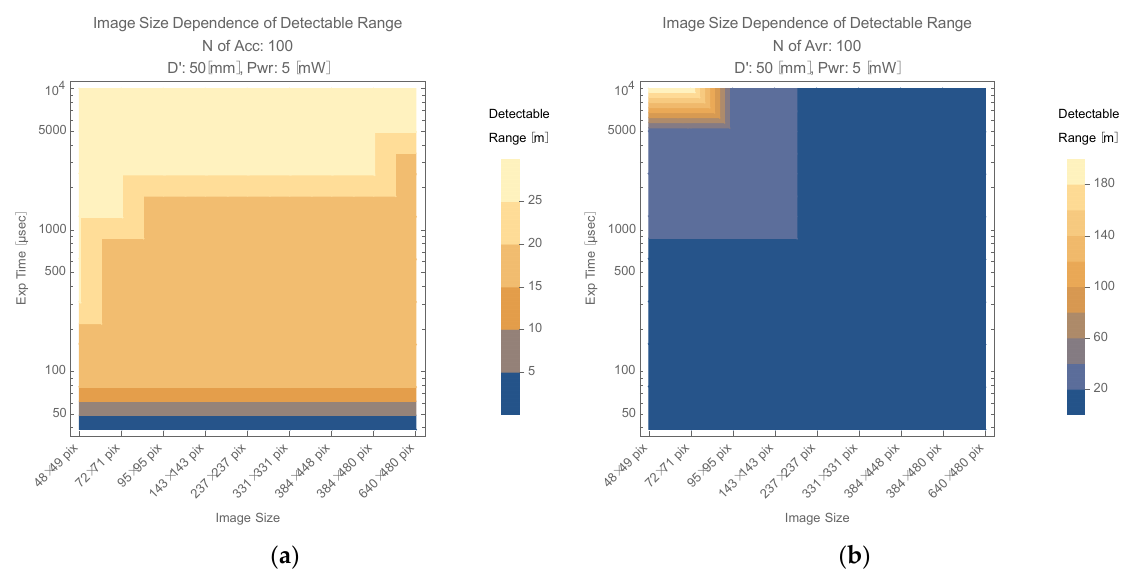
Figure 8. Detectable range plot for 50 mm camera optics’ diameter: ( a ) 100 accumulation; ( b ) 100 averaging.